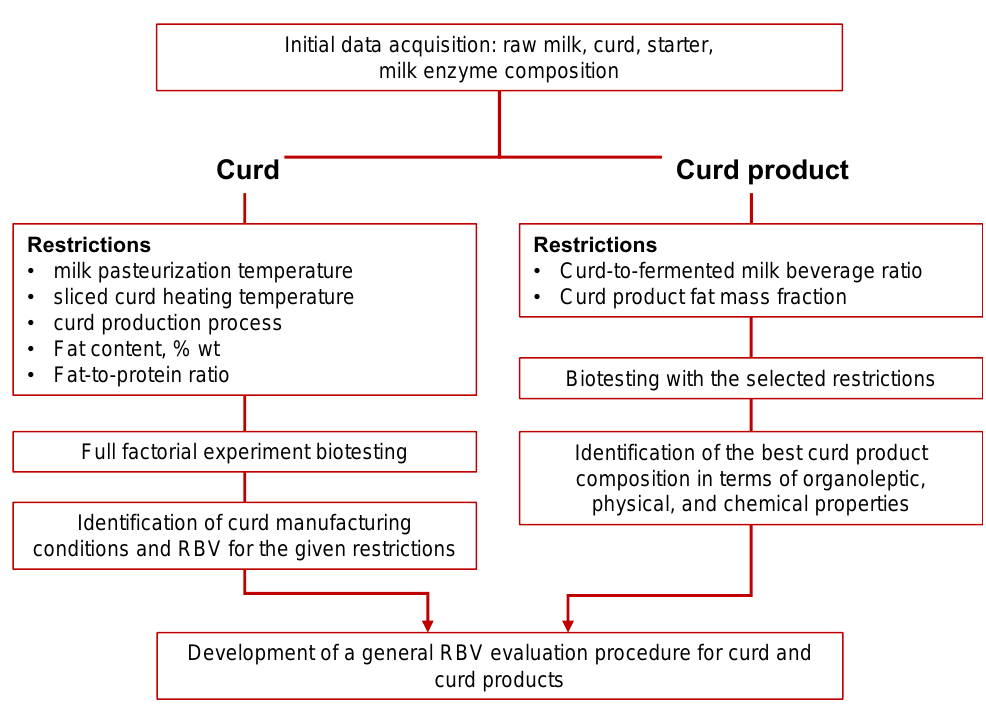
Figure 1. Modification of biotesting-based, fermented dairy product design for curd and curd prod- ucts.